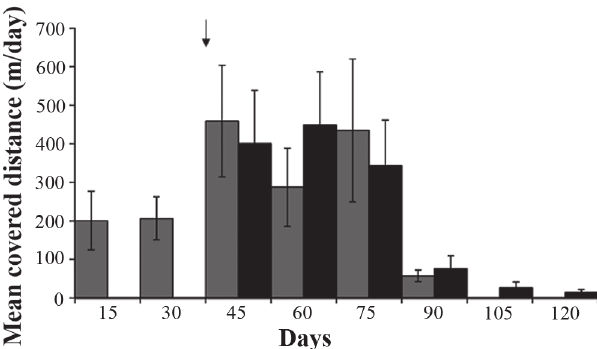
Fig. 4 . Mean covered distance by day during 15 days periods of batch 1 (grey bars) and batch 2 (black bars). The vertical arrow indicates the release of batch